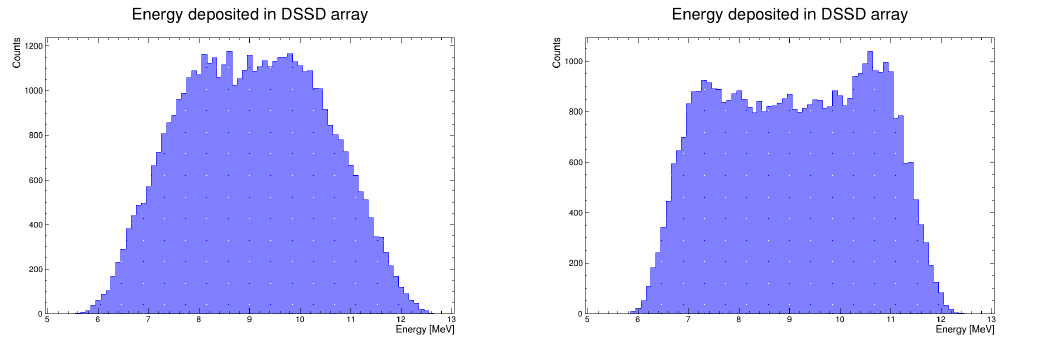
Figure 6: A comparison of the distribution of energy deposited in the DSSD array by a product 16 O through the n -decay of 17 O ∗ from the 4.553 MeV state (left) and the 6.356 MeV state (right).